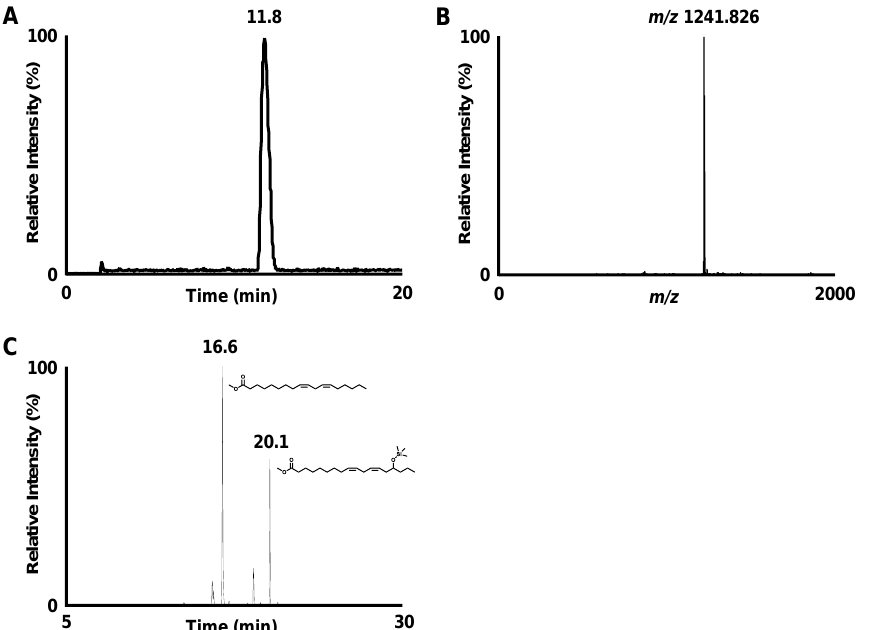
Figure 2. ( A ) LC-MS chromatogram of base peak chromatogram (BPC) of compound X analyzed under conditions described in Table 1 (Condition 3) and Table 2 (Condition 1), and ( B ) spectrum of the peak at 11.8 min. ( C ) GC-MS chromatogram of total ion chromatogram (TIC) of the hydrolyzed and derivatized compound X. The two peaks were identified as methyl linoleate (16.6 min) and methyl 15-hydroxy linoleate with a TMS group on the hydroxy group (20.1 min) by a spectral library